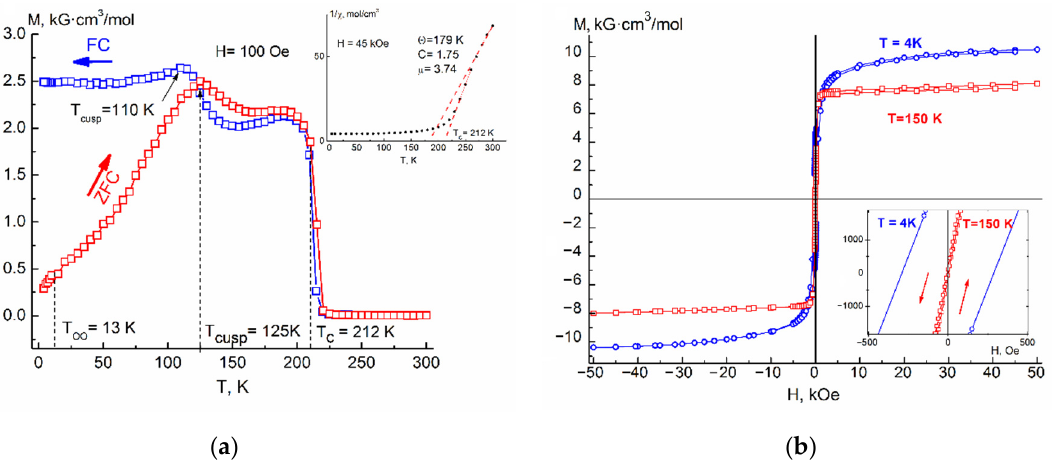
Figure 3. ( a ) Dependences of the M vs. Т of FC and ZFC magnetization for Fe 0.85 Ag 0.15 Cr 2 S 4 in a 100 Oe field. Inset: dependence of the inverse magnetic susceptibility versus temperature for this composition. ( b ) Dependences of the magnetization versus magnetic field for Fe 0.85 Ag 0.15 Cr 2 S 4 at 4 and 150 K.